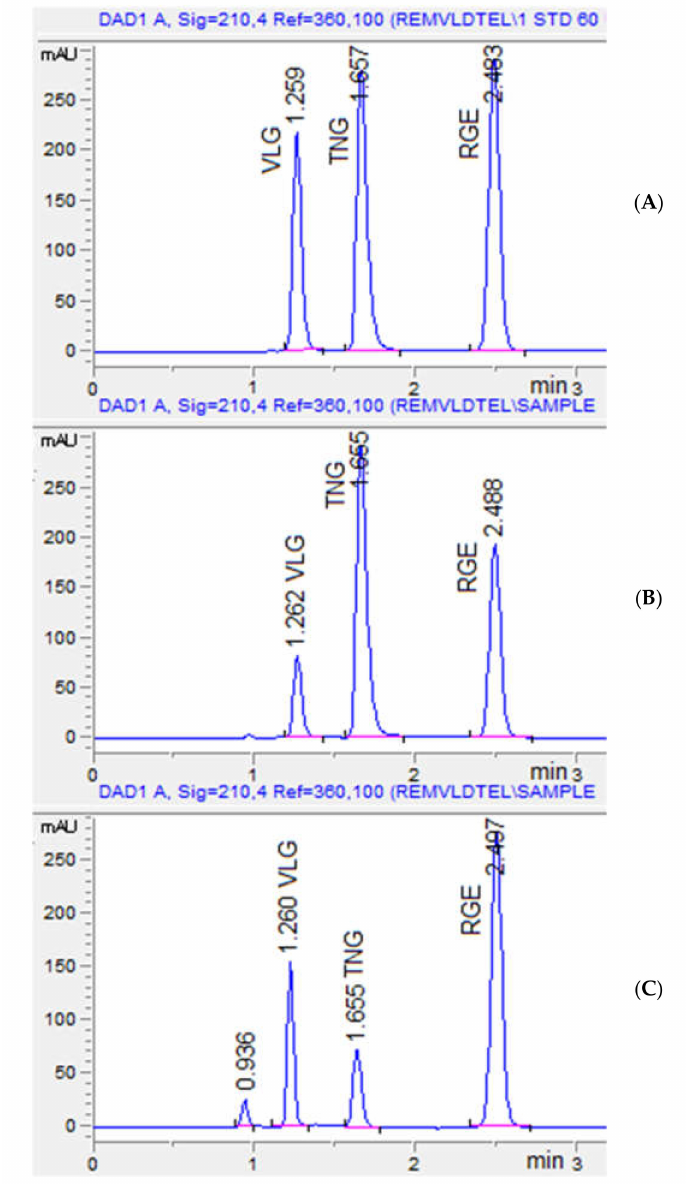
Figure 5. Representative chromatograms for standard ( A ), VLG + RGE formulation with IS TNG ( B ), and TNG+ RGE with IS VLG ( C ). The retention time of VLG was 1.26 min, TNG: 1.65 min, and RGE: 2.48 min. The peak at 0.936 is Ferric oxide yellow present in the TNG tablet